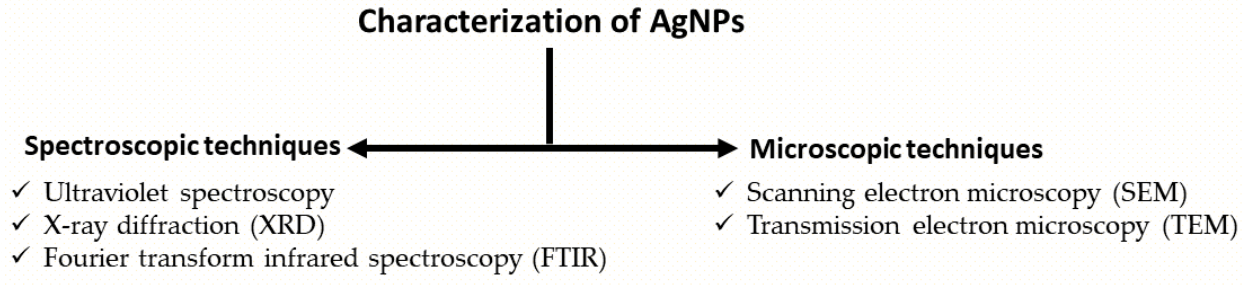
Figure 3. Different techniques used for characterization of nanoparticles.